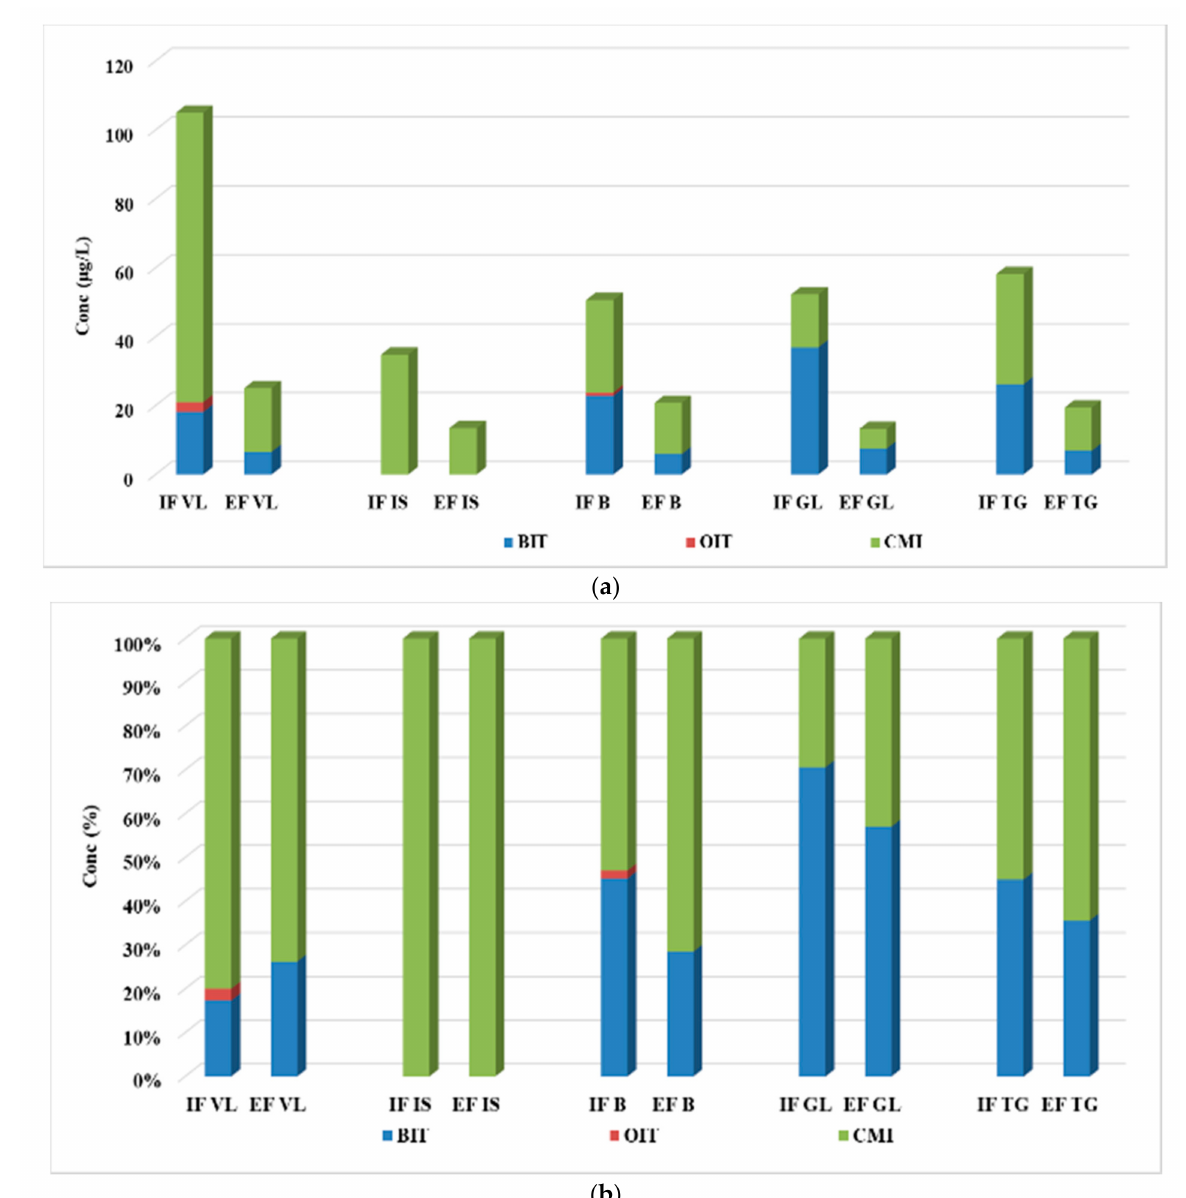
Figure 2. Variation ( a ) and distribution pattern ( b ) of the four-target biocide in wastewater